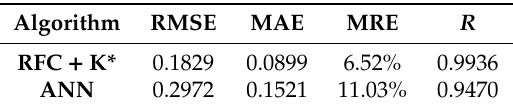
Table 3. Root-mean-squared error (RMSE) in mm / day, mean absolute error (MAE) in mm / day, mean relative error (MRE), and correlation coe ffi cient ( R ) for the prediction of the daily ETo using the two best regression algorithms, randomizable filtered classifier with K* algorithm (RFC + K*) and artificial neural network (ANN).